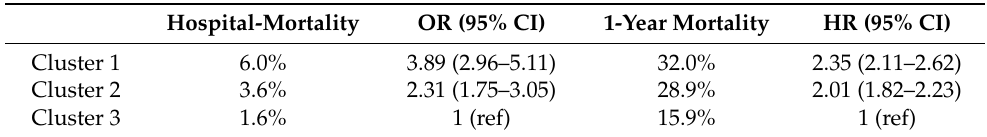
Table 2. Mortality outcomes according to